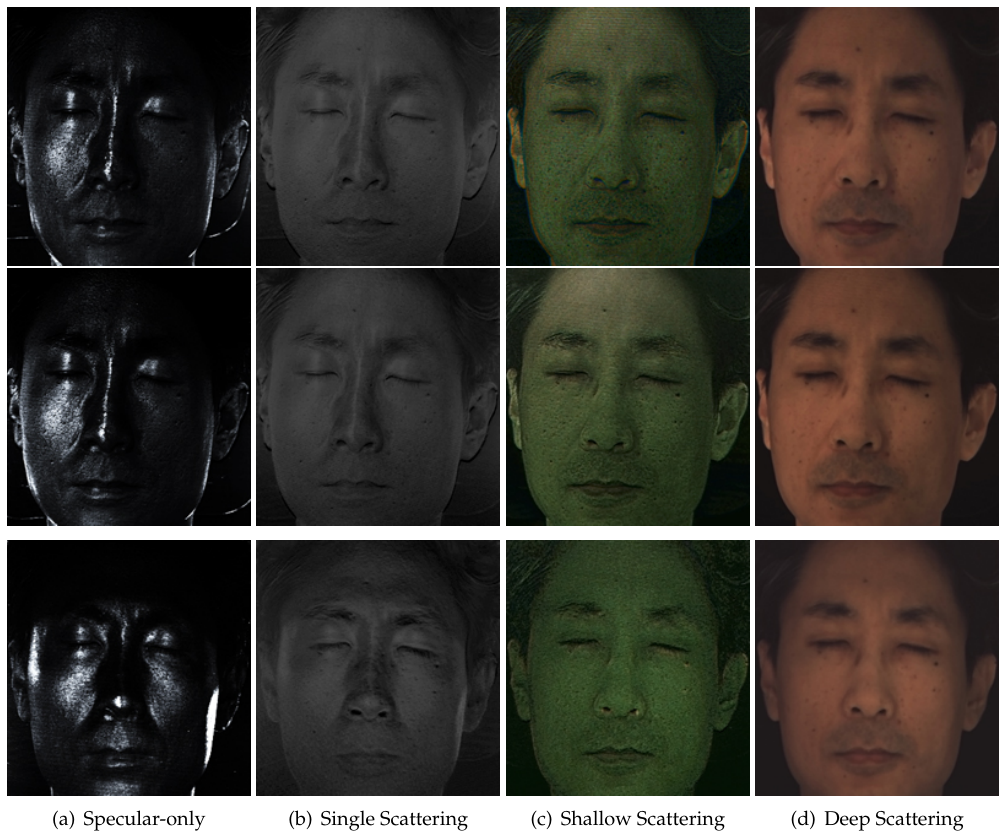
Figure 11. Layered reflectance separation depending on distance between a subject and a Lytro Illum camera for TPLF imaging under polarized spherical illumination. The subject was placed inside a spherical light stage at a near (top row), a middle (middle row) and a far distance (bottom